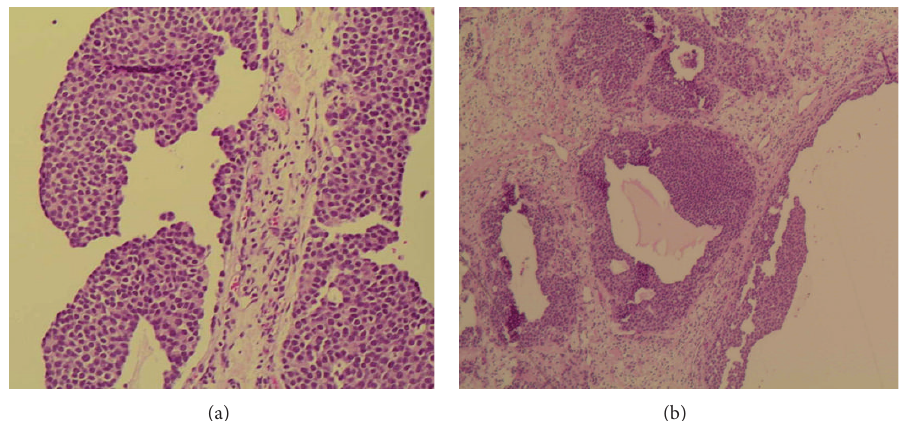
Figure 2: Photomicrograph showing (a) uniform basaloid tumour cells with stippled chromatin and a moderate amount of pale, eosinophilic cytoplasm (H&E; X 10) and (b) cystic changes within the tumour (H&E; X